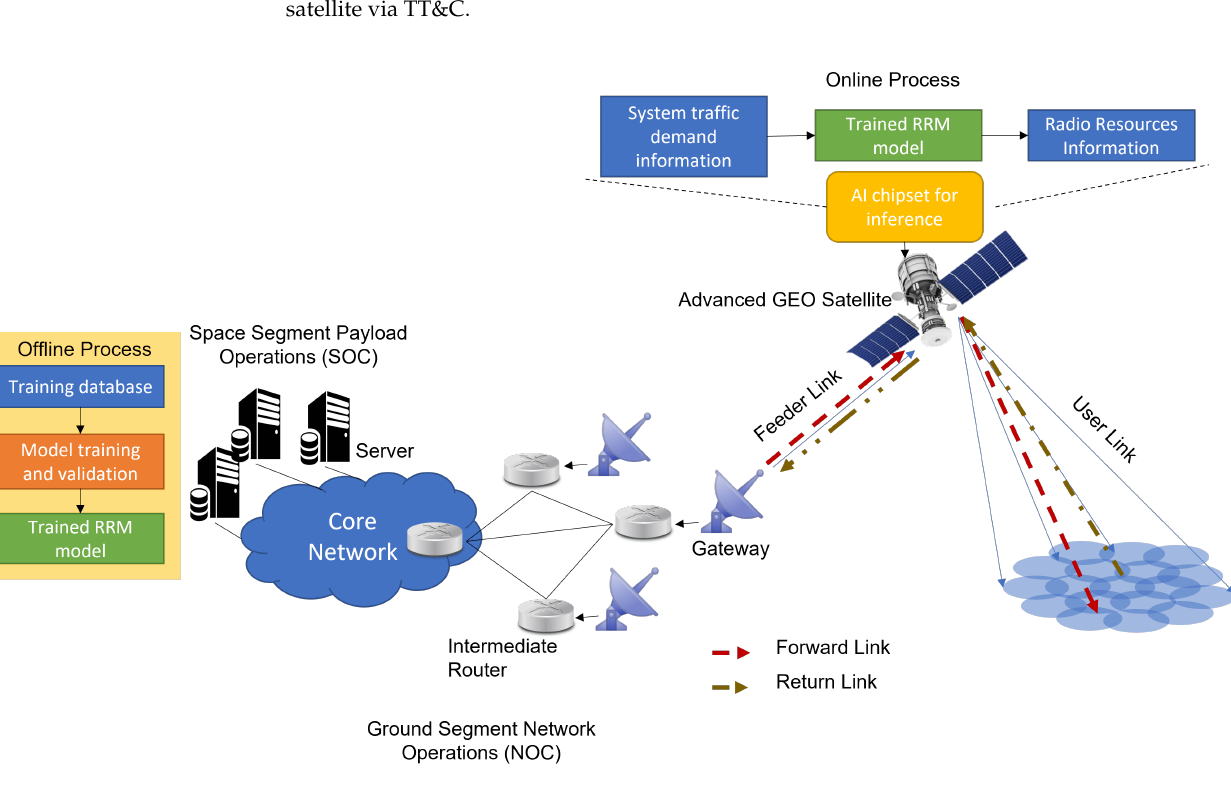
Figure 2. AI Chipset implementation in the ground segment for RRM in a multibeam satellite system. ML algorithm training is performed online in the ground segment using the information received on the return link updating the model for the RRM and sending the necessary configurations on the satellite via TT&C.